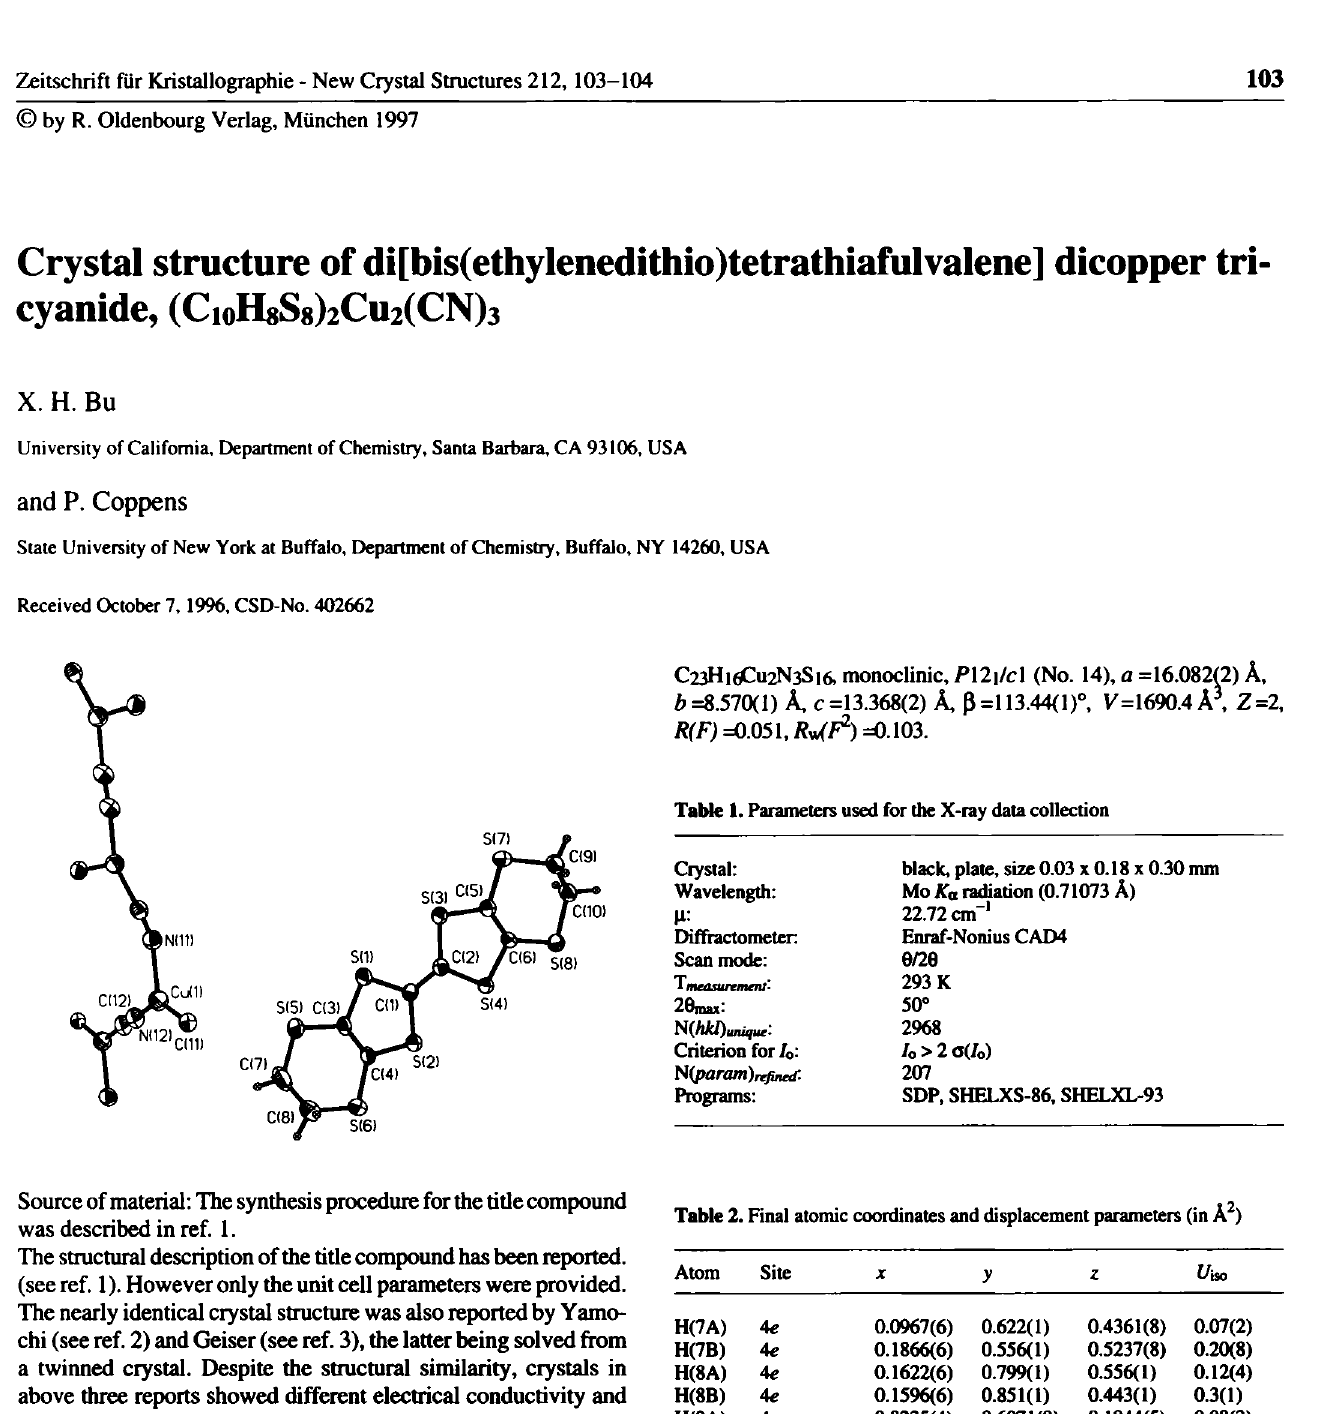
Table 3. Final atomic coordinates and displacement parameters (in A 2 )